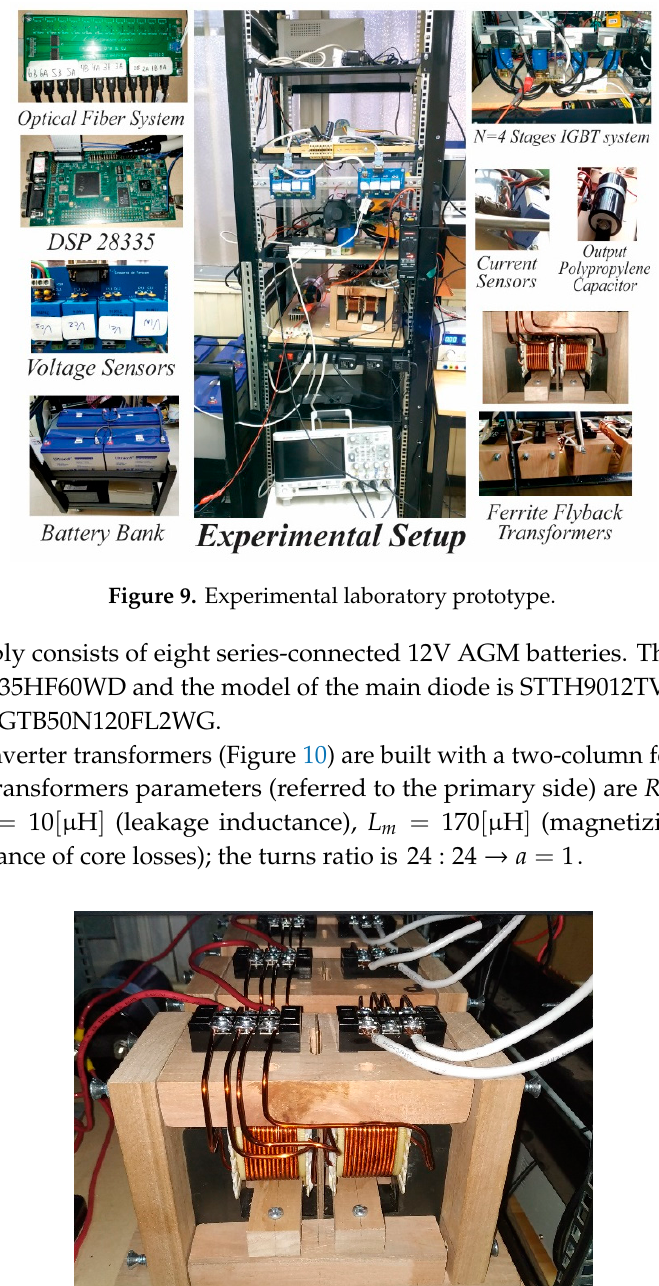
Table 1. Experimental parameters.